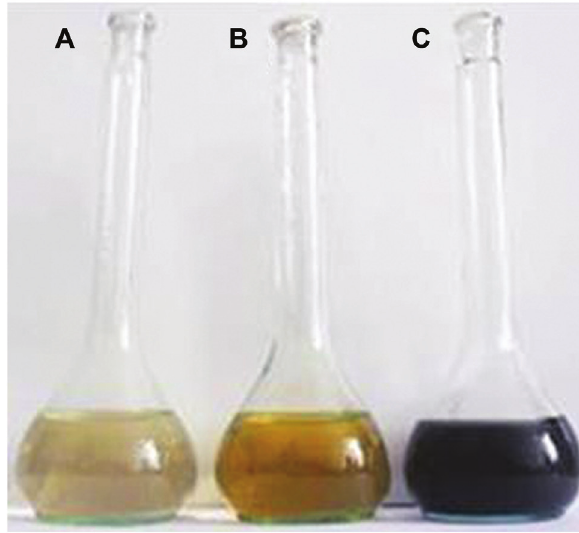
Figure 2: Evolution of the color of the reaction solution of silver nitrate (0.01 m), ethanol (96%), and ammonia (25%) sonicated for (A) 8 min, (B) 11 min, and (C) 25